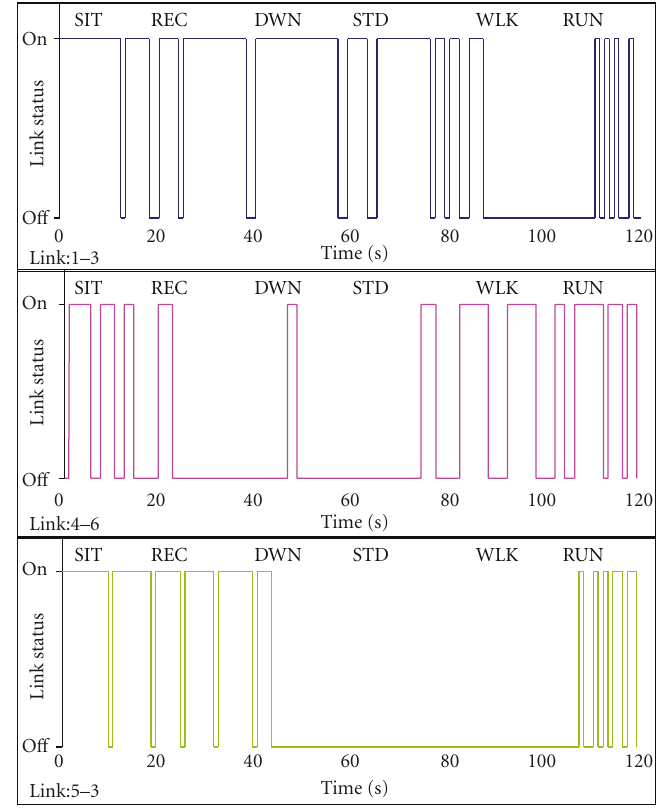
Figure 2: Variation of instantaneous link connectivity with postural